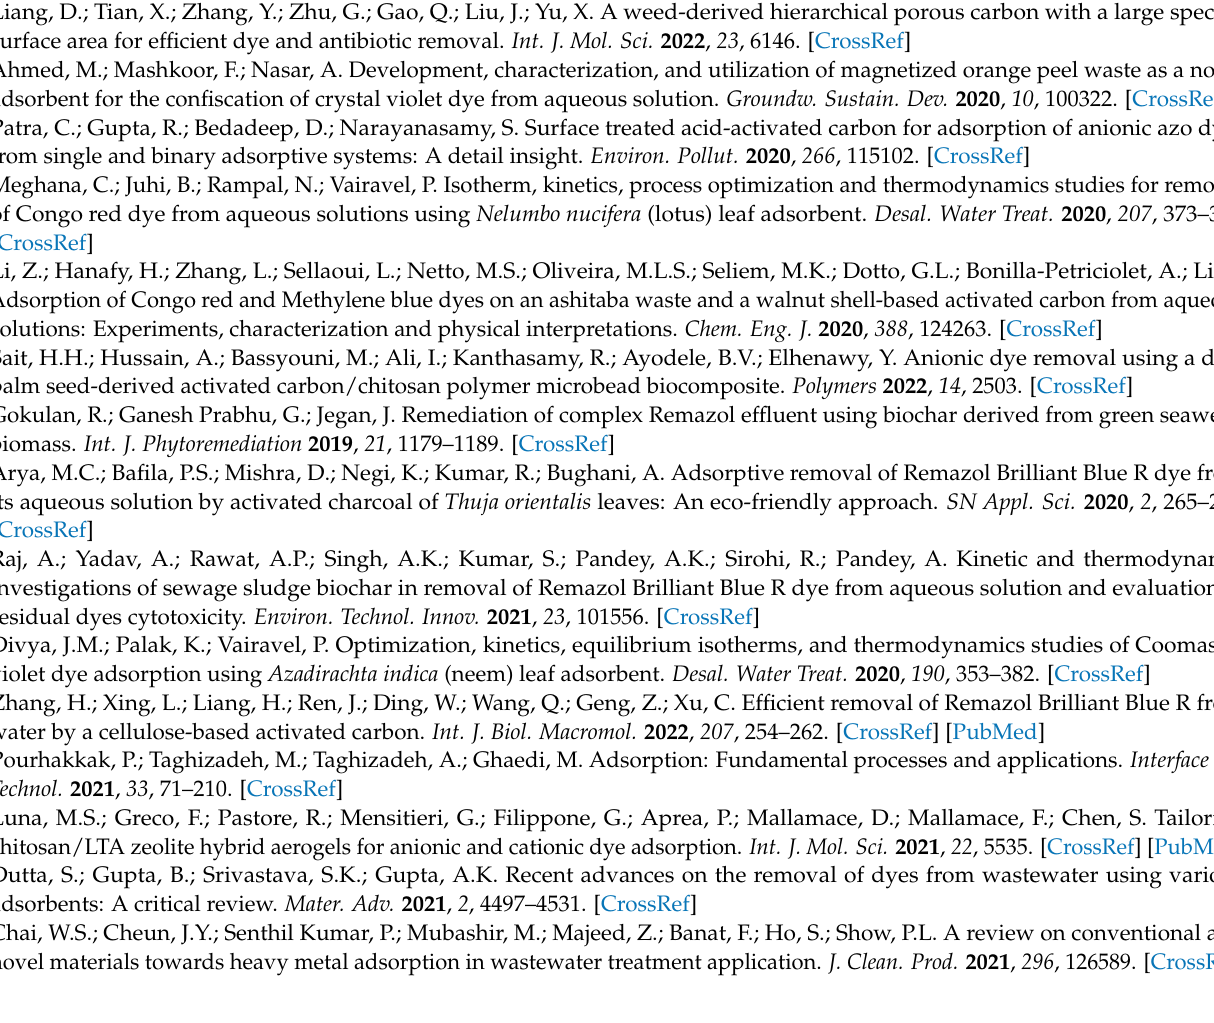
Table S3: Activation energy for the adsorption of RBBR dye onto WSBAC adsorbent at various initial dye